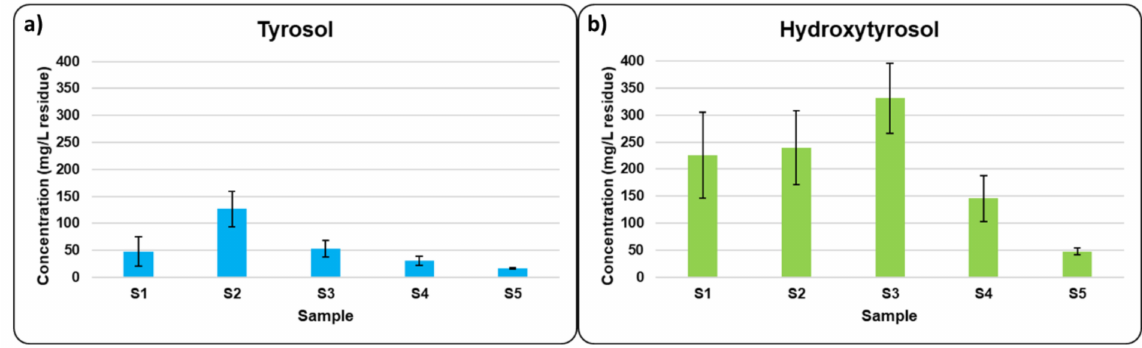
Figure 7. Tyrosol ( a ) and hydroxytyrosol ( b ) content in each table olive processing wastewaters sample.